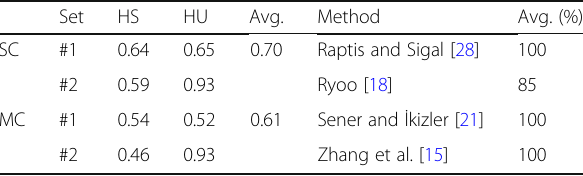
Table 3 Single-class (SC) and multi-class (MC) AuC for UT- Interaction (left). Classification accuracies reported on UT- Interaction (right). Reported values are for σ =